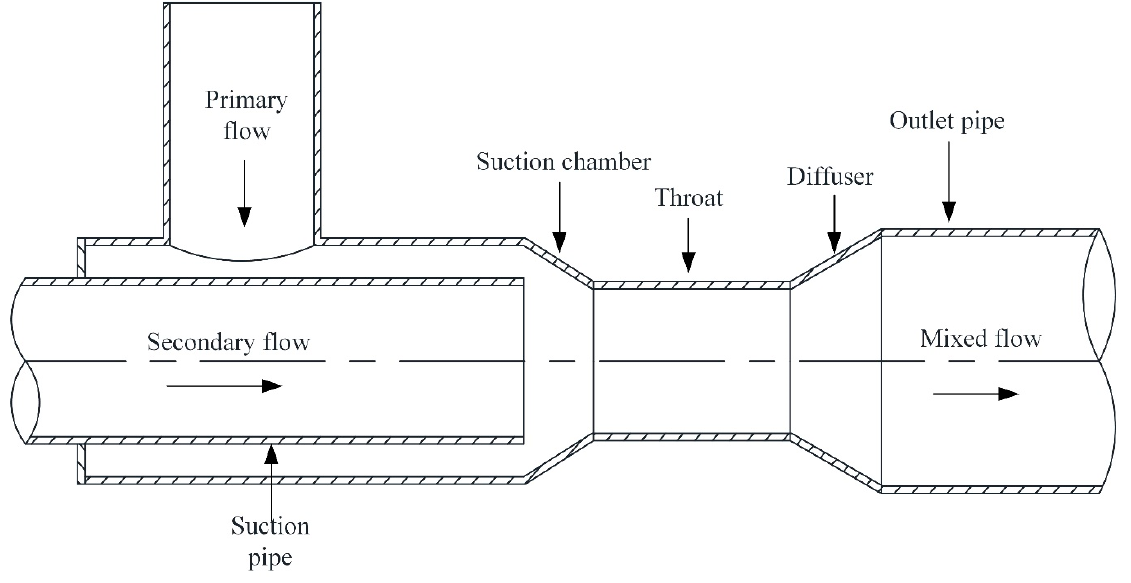
Figure 1. Structural schematic drawing of annular jet pump.